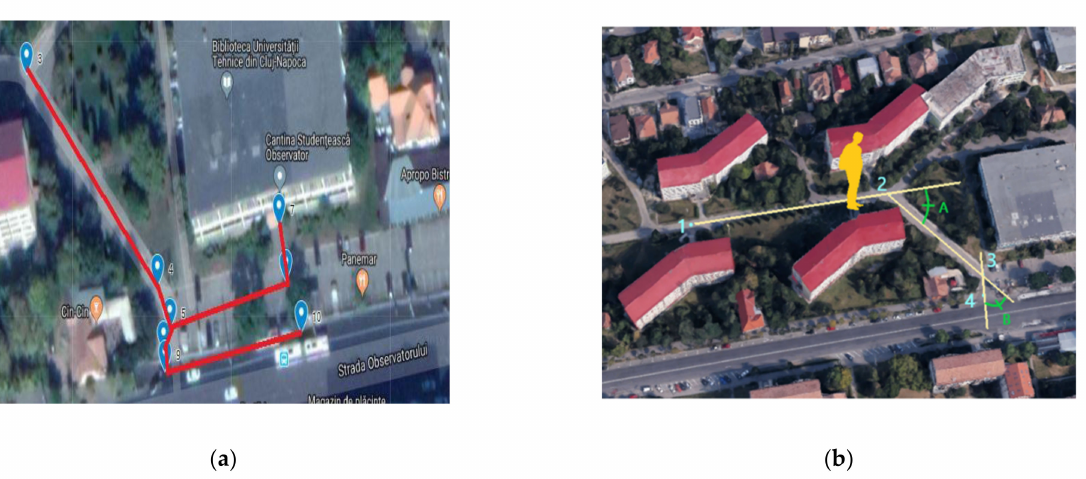
Figure 10. Navigation mode real scenario: ( a ) numbered markers and possible routes using Google My Maps; ( b ) testing Navigation mode , 1—starting point: 2, 3—change direction points: 4—destination